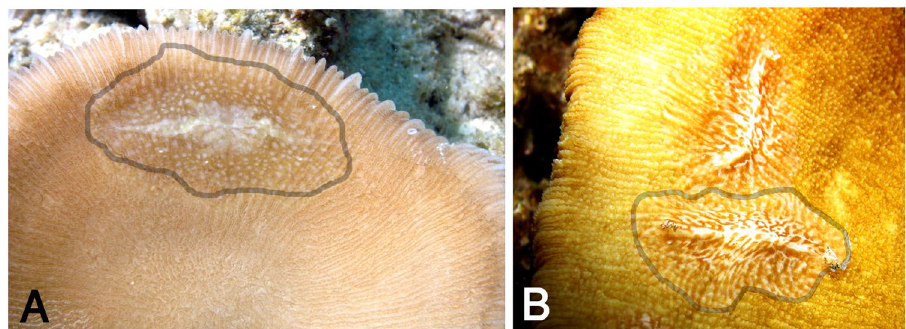
Figure 5. Benthic ctenophores living on the underside (aboral) of mushroom corals. ( A ) An unidentified Coeloplana species collected from Cycloseris costulata in Tun Mustapha Park, northernmost tip of Borneo, Sulu Sea; ( B ) The recently described new species Coeloplana loyai living on Herpolitha limax in the Gulf of Aqaba, Red Sea. The gray line outlines the ctenophores. ( B Photo credit: Eran